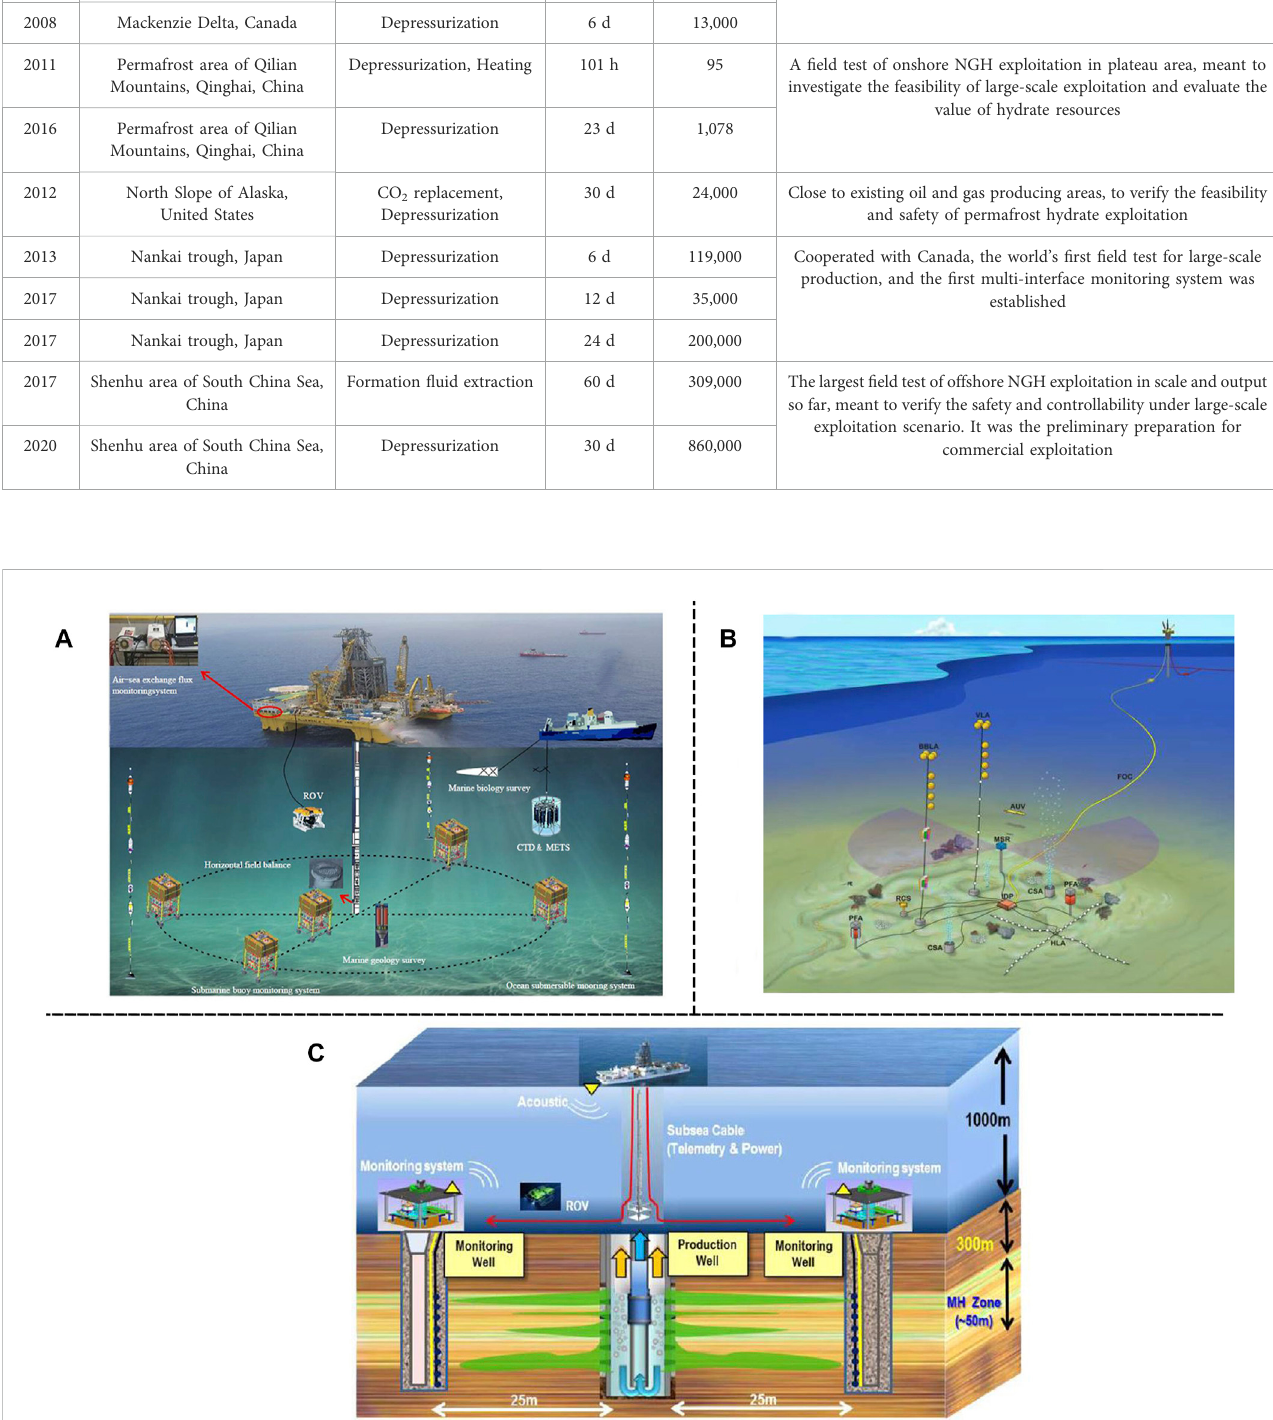
FIGURE 1 Current monitoring systems for NGH fi eld test. Image (A) “ Four-in-one ” environmental monitoring system employed during South China Sea NGH production fi eld test in 2017 (Li et al., 2018). Image (B) illustration of the sea fl oor observatory at the Woolsey Mound (Mississippi Canyon Lease Block 118, MC118) in 2012 (Macelloni et al., 2012). Image (C) production and monitoring systems at Nankai Trough in 2013 (Chee et al.,